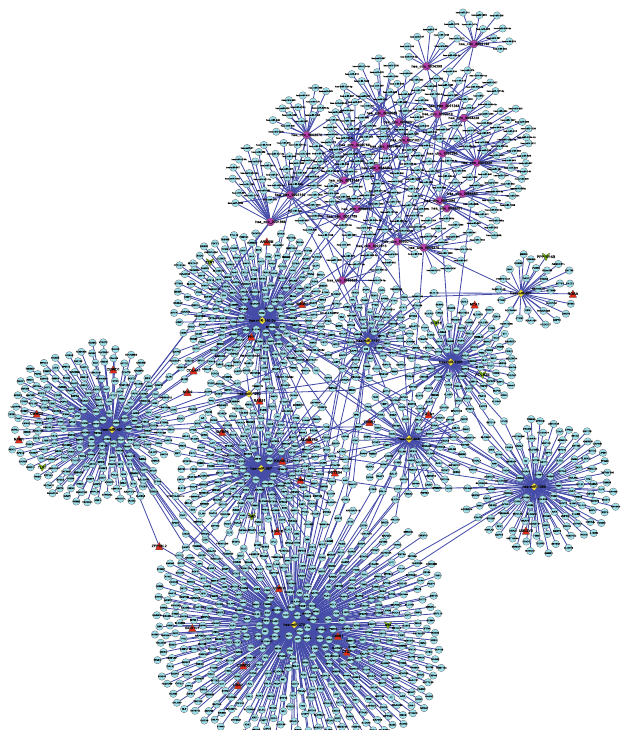
Figure 3: The circRNA-miRNA-mRNA regulatory network in GC. The circular nodes in blue represent mRNAs; the diamond-shaped nodes in yellow represent miRNAs, and the octagonal nodes in purple represent circRNAs. The triangular nodes in red indicate upregulated DE mRNAs, and the V nodes in green indicate downregulated DE